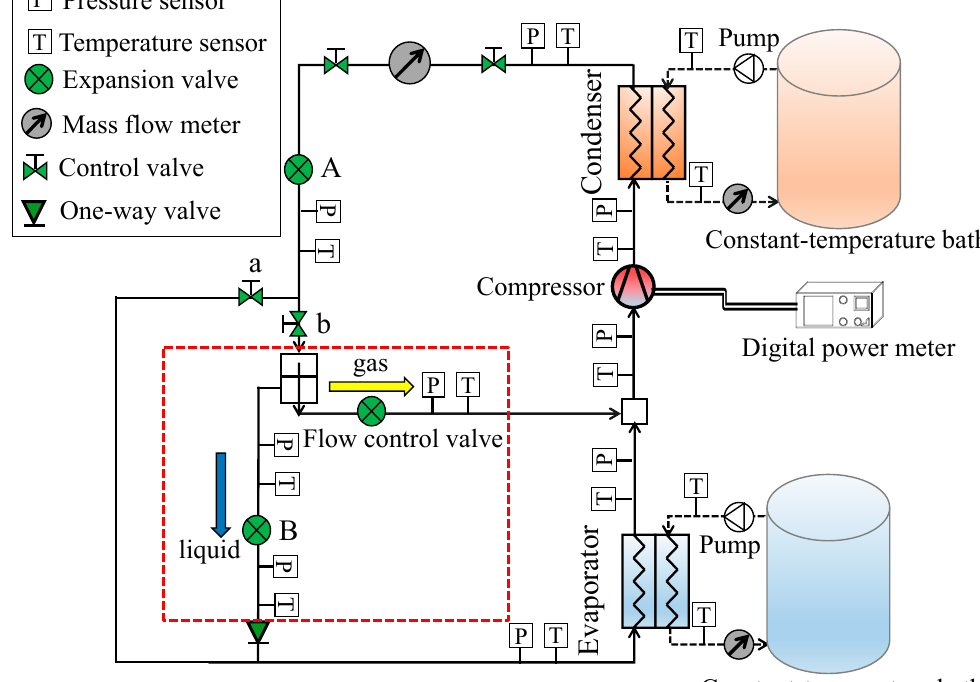
Figure 2. Schematic diagram of the experimental setup.